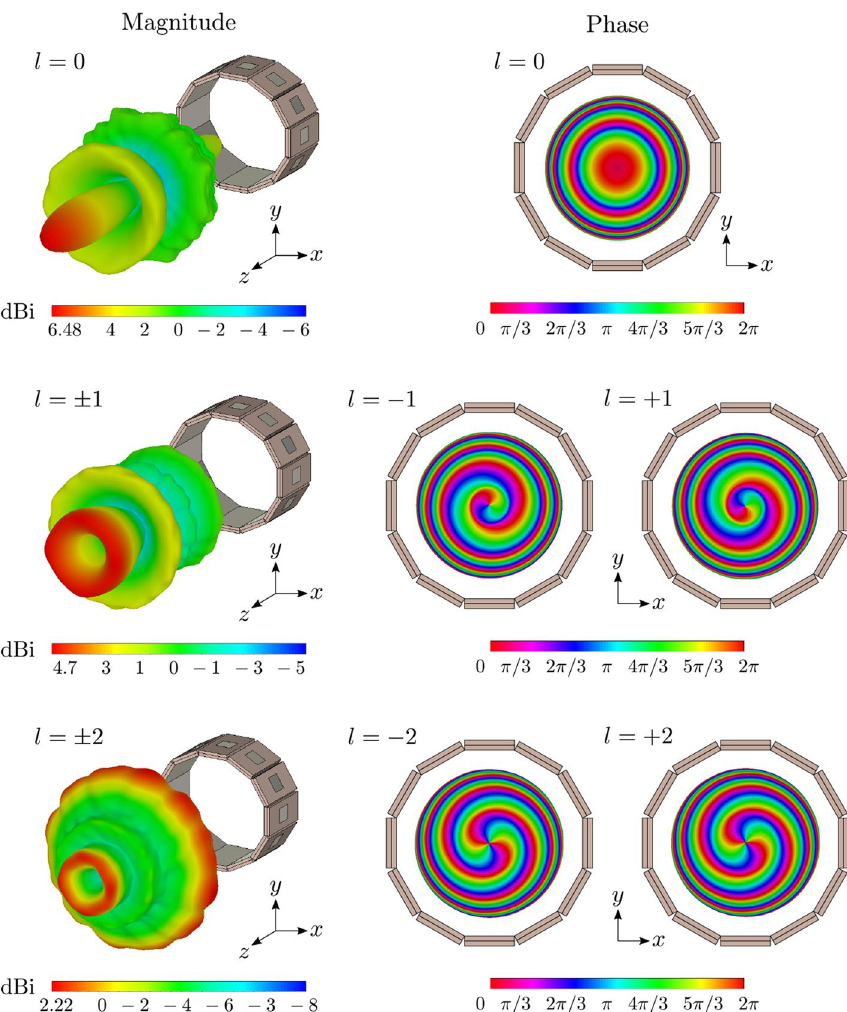
in dB scaling. Phase helical structures occurs for modes l ± 1, ± 2 with an optical vortex in the center, while for mode l = 0 , phase is not helical, but forms multiple disconnected concentric circular surfaces. The difference between positive and negative OAM modes in terms of phase is that, in the first case the phase increases clockwise, while in the second case